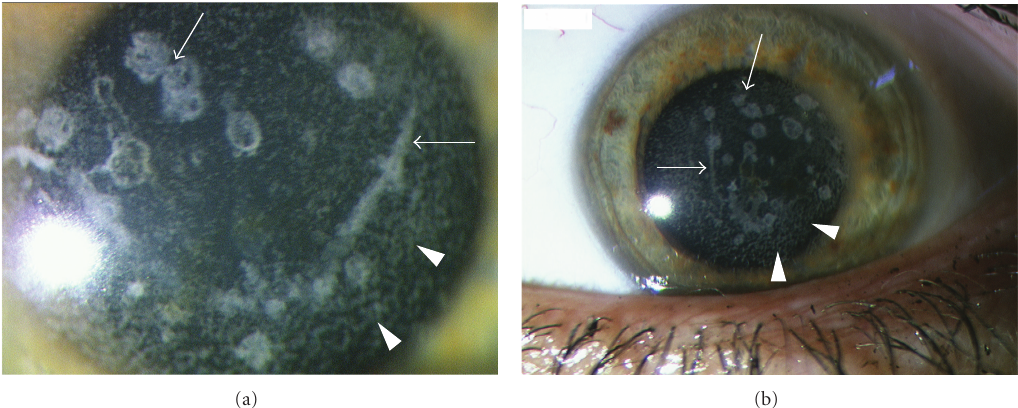
Figure 1: Slit-lamp examination shows multiple bilateral (a: right eye; b: left eye) crumb-like and lattice-like opacities of the stroma (arrows) and multiple foci of fine granular infiltrates at the surgical flap interface (arrowheads).